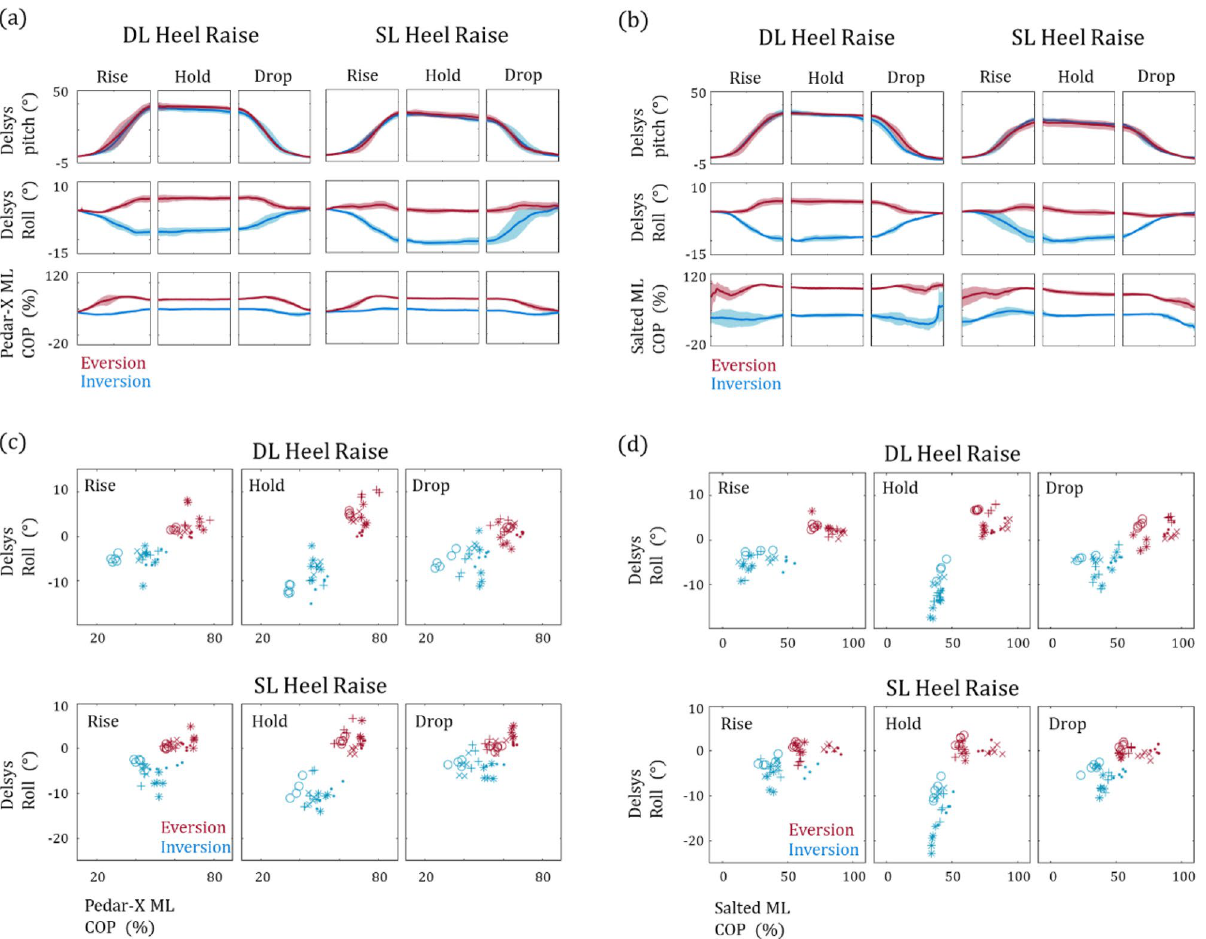
Figure 3. Analysis of medial–lateral foot pressure distribution during heel raise. ( a ) A representative plot of foot orientation and medial COP progression obtained via Delsys Trigno sensors and Pedar-X, respectively, during five heel raise events. The double and single leg conditions are shown on the right and left, respectively. The red lines depict heel raises with ankle eversion and the blue lines represent inversion. ( b ) Data obtained from the same subject but with the smart insoles are shown. The roll plotted against the ML COP, obtained from Pedar-X, and MPP which was obtained from the smart insoles are shown in ( c ) and ( d ), respectively. The data points represent the mean within their respective phase for each event. The double and single leg heel raise data are shown on the top and bottom panels,